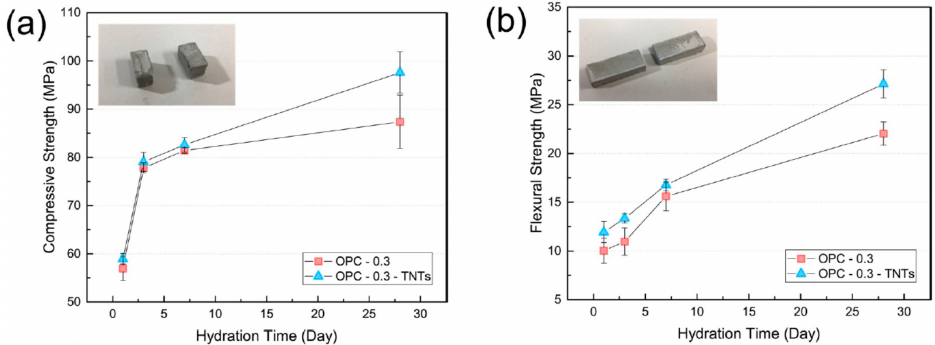
Figure 10. ( a ) Compressive and ( b ) flexural strength of ordinary Portland cement paste with TNTs (w / c =